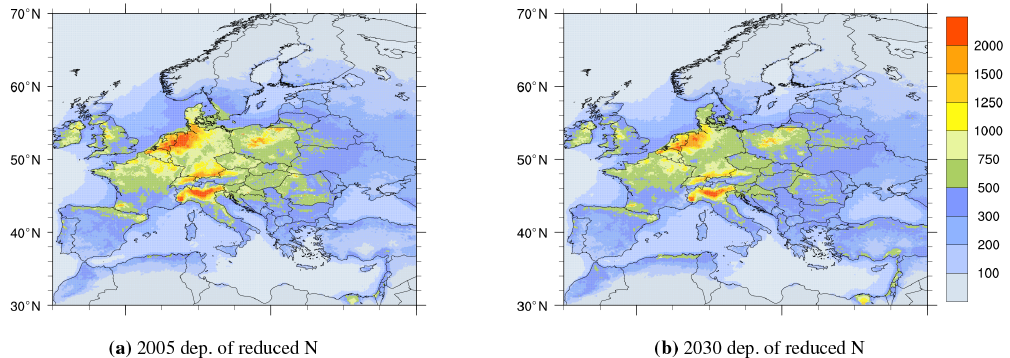
Figure 3. Deposition of reduced N in 2005 (a) and in 2030 (b) (mgNm − 2 yr − 1 ).